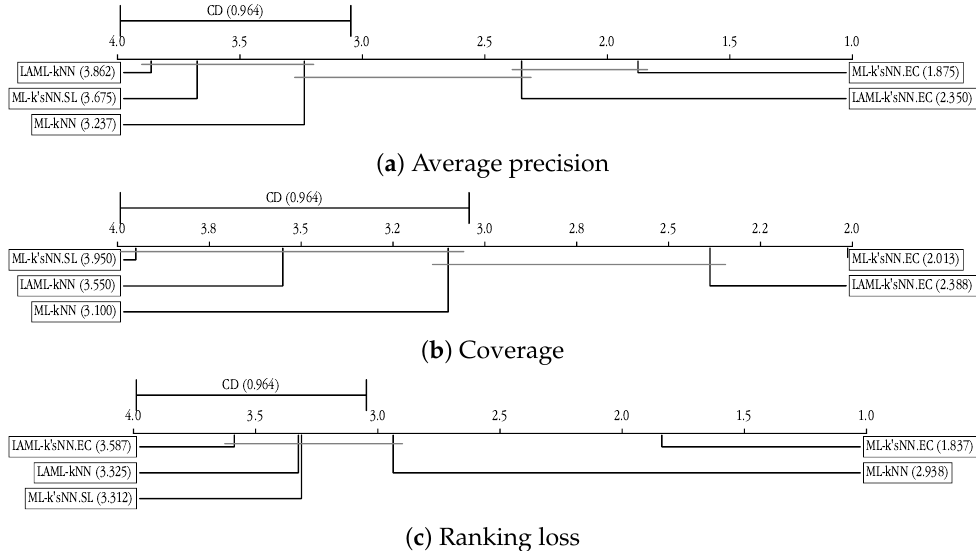
Figure 4. Nemenyi test for the different methods and the different ranking